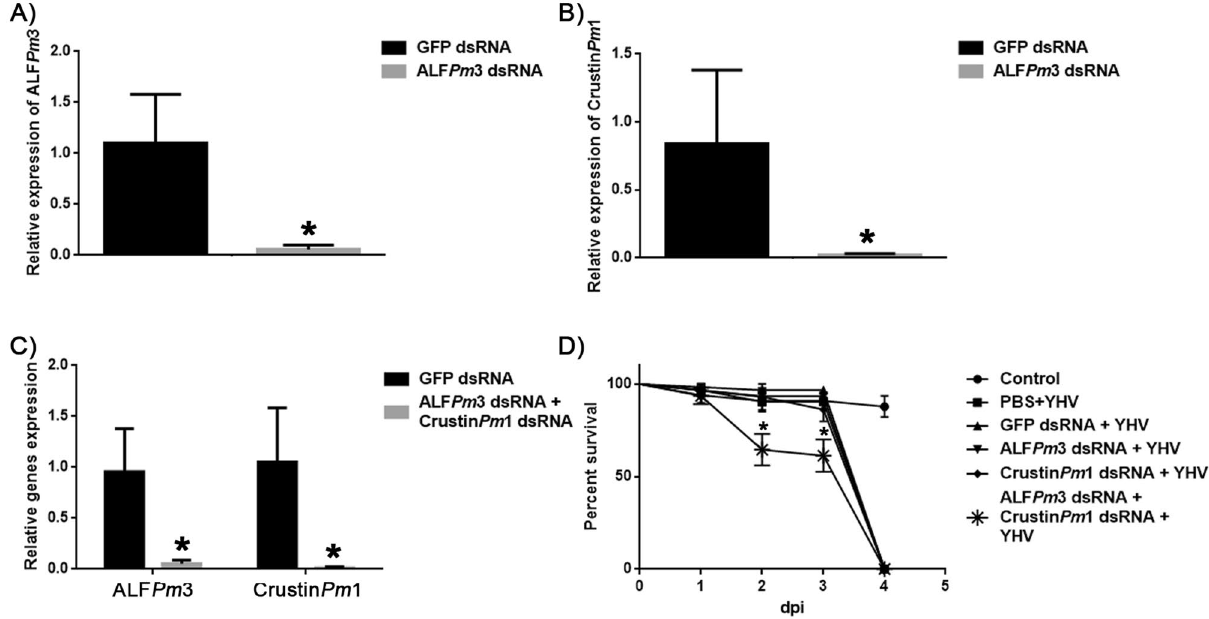
Figure 6. Effect of ALF Pm 3 and Crustin Pm 1 knockdown during YHV infection. Determination of ALF Pm 3 and Crustin Pm 1 transcript level in P. monodon hemocytes after shrimp were double injected with either 1 µg of ALF Pm 3 dsRNA per 1 g shrimp ( A ) or 1 µg of Crustin Pm 1 dsRNA per 1 g shrimp ( B ) or both ( C ). ( D ) Percent survival of ALF Pm 3 or Crustin Pm 1 knockdown shrimp upon YHV infection. Shrimp were divided into 6 groups, including PBS (control), YHV-challenged, YHV-challenged + GFP knockdown, YHV-challenged + ALF Pm 3 knockdown, YHV-challenged + Crustin Pm 1 knockdown and YHV- challenged + ALF Pm 3/Crustin Pm 1 knockdown. Each group contained 10 shrimps and the experiment was carried out in